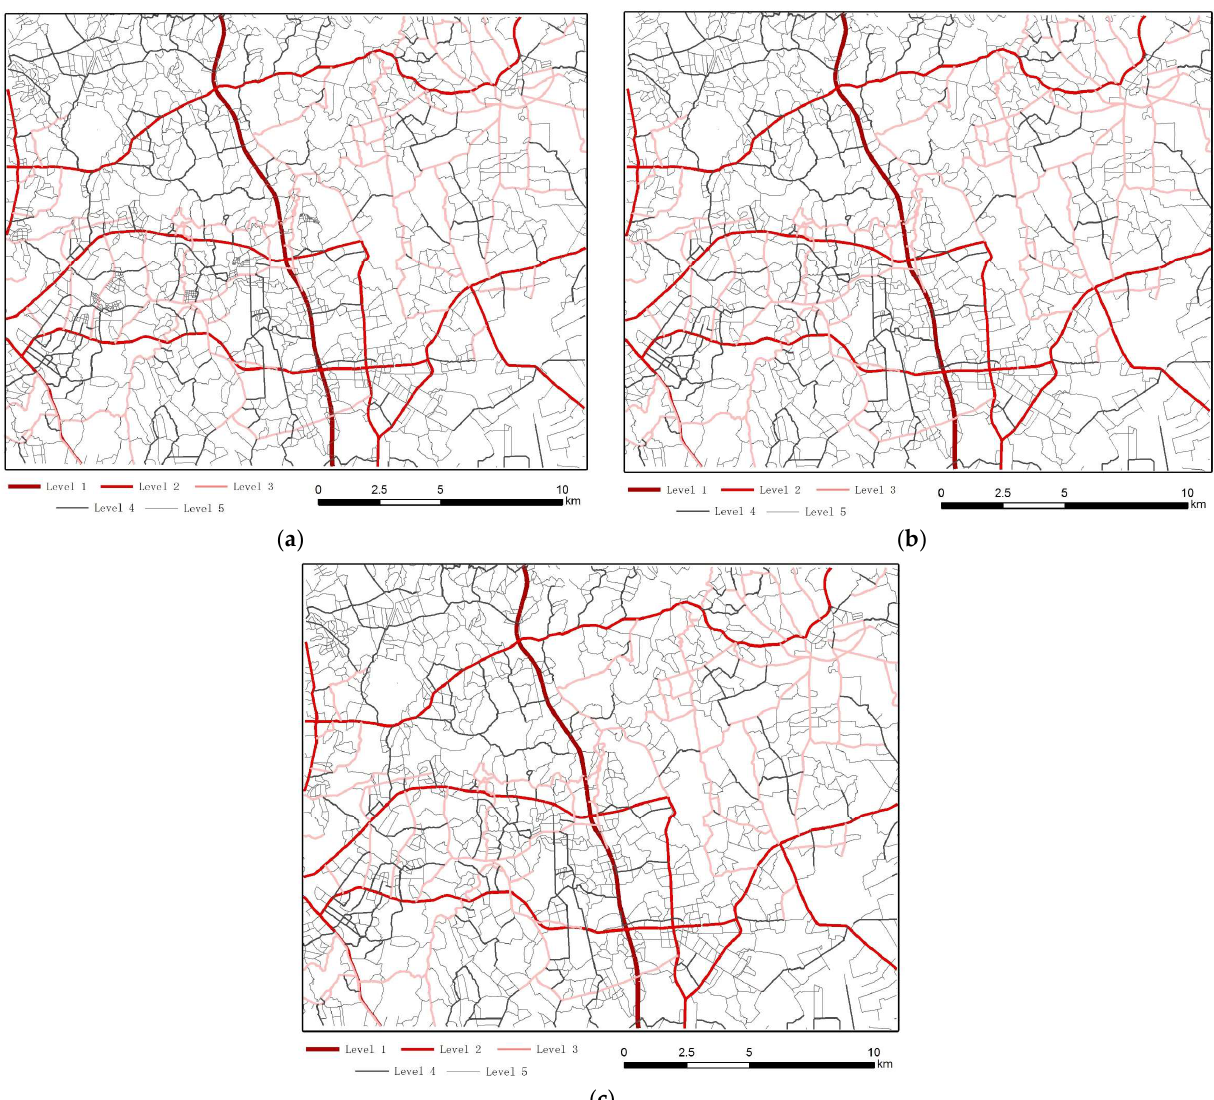
Figure 10. Experimental data and results: ( a ) original road network data; ( b ) selection result of the mesh-based method; and ( c ) selection result of the proposed method.